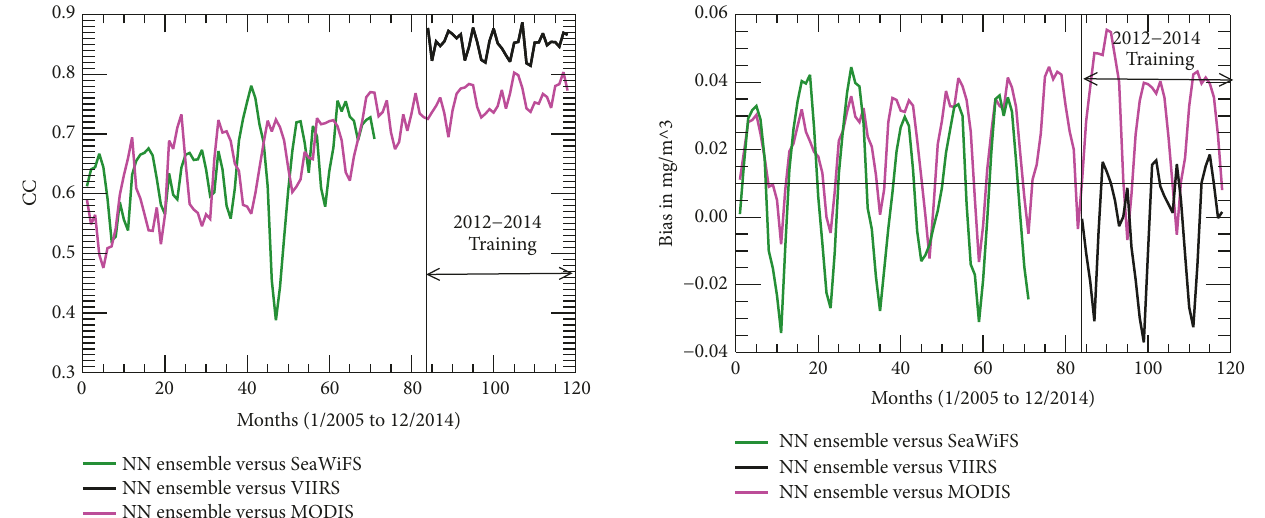
Figure 6: Correlation of monthly mean chl-a concentrations sim- ulated by the NN ensemble with VIIRS data (black curve), MODIS data (pink curve), and SeaWiFS data (green curve).